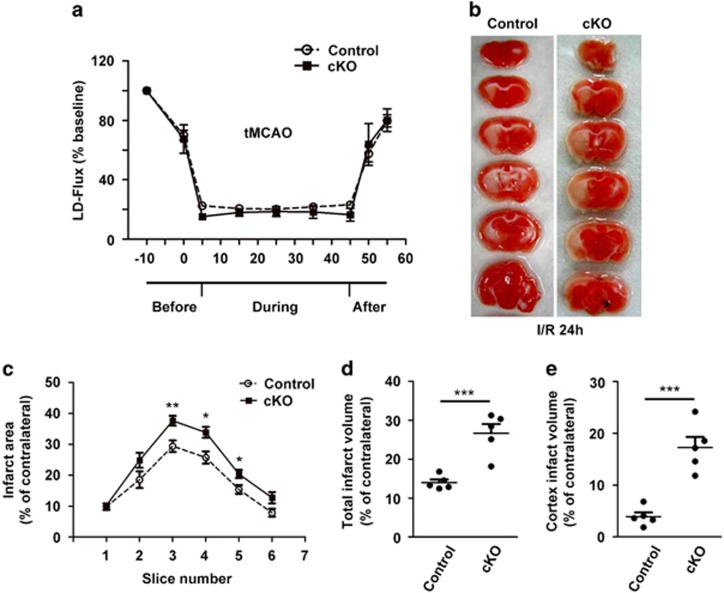
SENP1 deficiency exacerbates ischemic brain damage. (a) Regional cerebral blood flow (rCBF) in the core of the middle cerebral artery territory of SENP1 cKO and littermate control mice before, during and after ischemia measured by laser Doppler flowmetry. Flow values from seven experiments are averages of 10 min intervals and are expressed as means±S.E.M. No difference was noticed between littermate control and SENP1 cKO mice. (b) Photomicrographs of TTC-stained brain sections (1 mm) showing brain infarction at 24 h after the onset of ischemia in littermate control and SENP1 cKO mice. Representative of five experiments for each. (c–e) Quantification of infarct areas (volumes) in ipsilateral hemisphere normalized to the total areas (volumes) of the corresponding contralateral hemisphere in sequential coronal brain slices (c), the entire brain (d) and the cortical regions (e). For (d) and (e), results for individual animals are shown as dots and means±S.E.M. are indicated as horizontal lines *P<0.05, **P<0.01, ***P<0.001 by Student's t-test